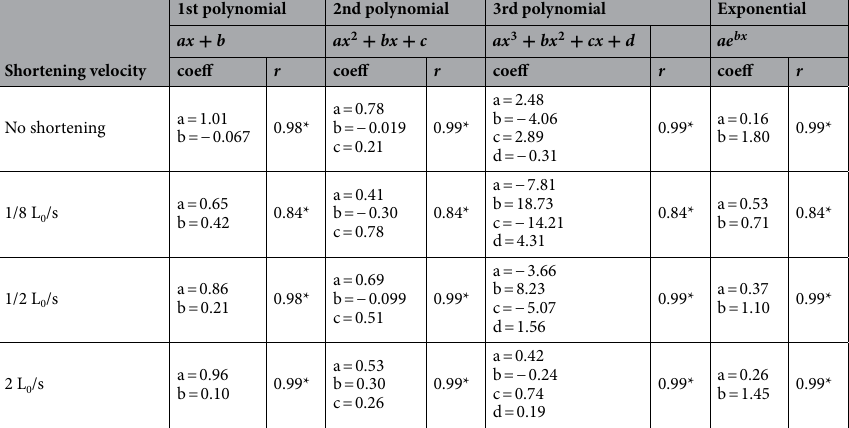
Table 4. Coefficients and correlation for the linear and the non-linear relationships including 2nd order polynomial, 3rd order polynomial and exponential function between muscle force and stiffness during the isometric force redevelopment period following active shortening at three velocities (1/8, 1/2 and 2L 0 /s) and with no shortening. * p <